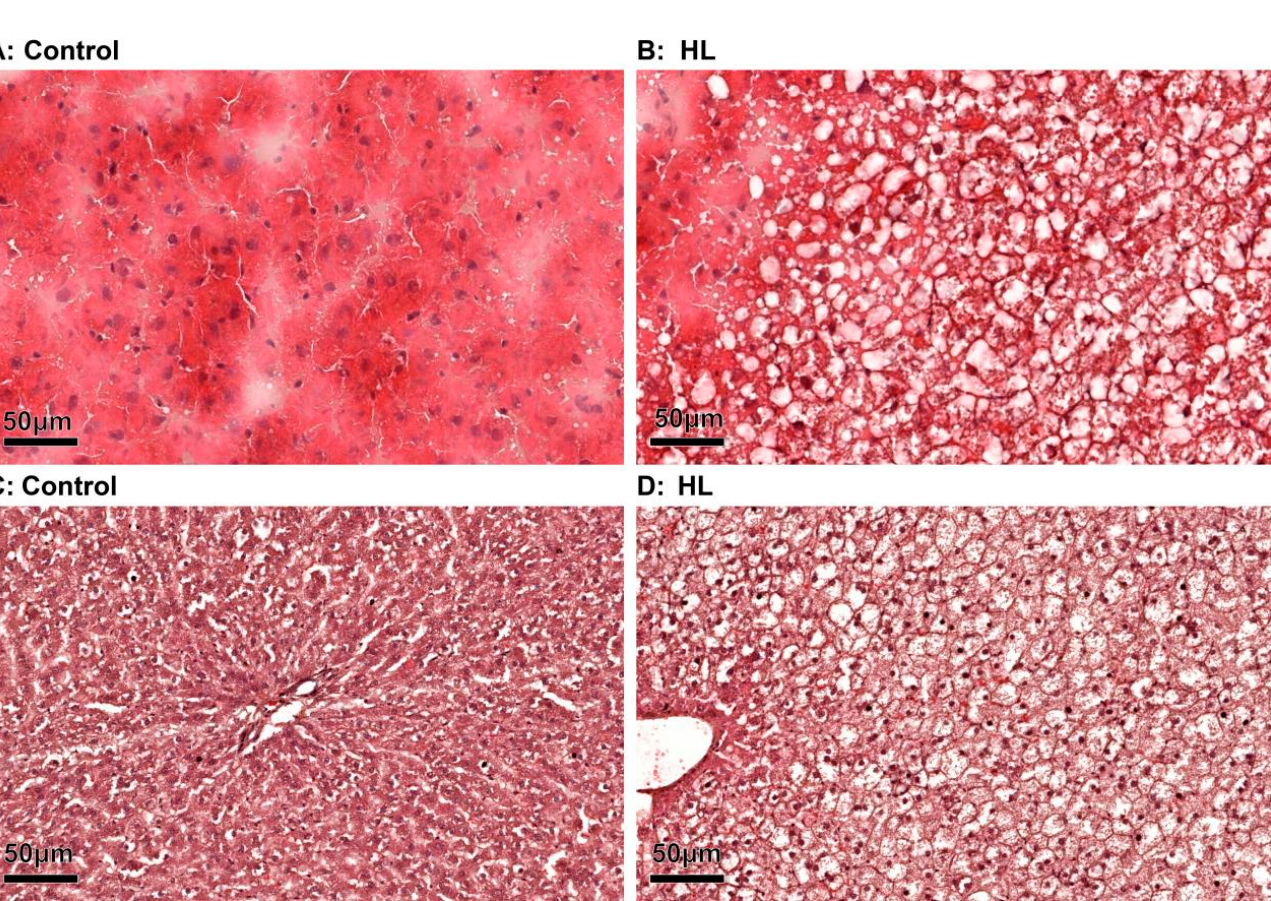
Figure 1. Observation of fat deposition in liver tissues under a light microscope (H&E staining ×200). ( A ) H&E staining from frozen sections in control of rat liver; ( B ) H&E staining from frozen sections in HL of rat liver; ( C ) H&E staining from paraffin sections in control of rat liver; ( D ) H&E staining from paraffin sections in HL of rat liver. The scale bar is 50 μ m; n = 3; the sample repeat for each group was three rats.